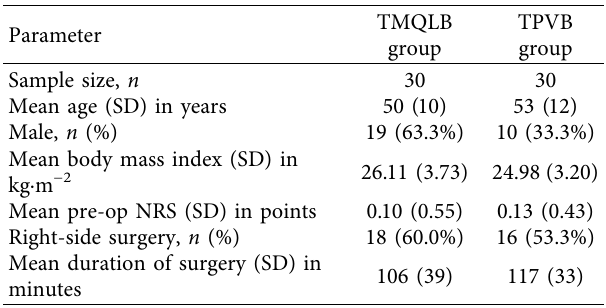
Figure 2: Consolidated standards of reporting trials fow diagram showing patient progress through the study phases. Table 1: Patient